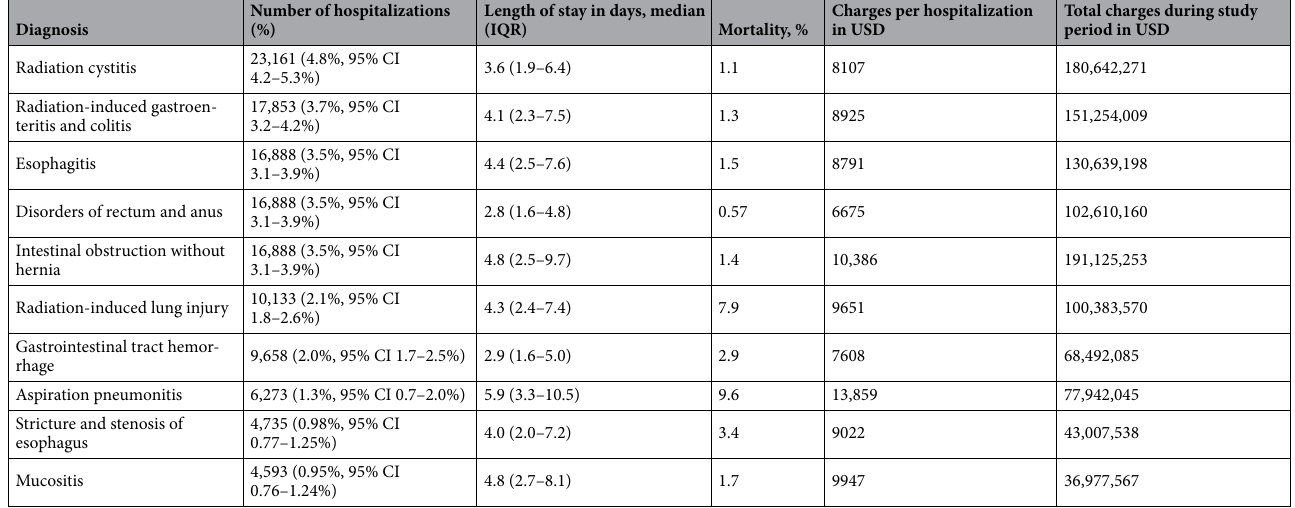
Table 2. Number of hospitalizations, hospital length of stay, in-hospital mortality, and charges for top 10 complications of radiotherapy,